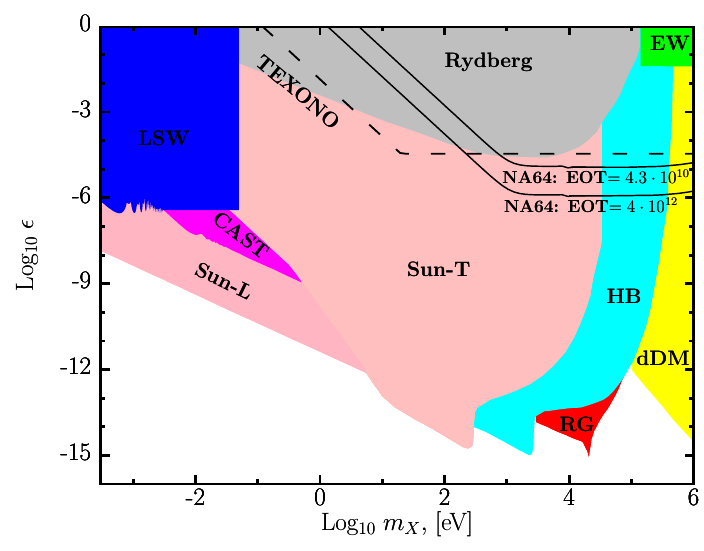
Figure 1 . Exclusion limits in the ( m X ; (cid:15) ) parameter plane of the hidden photon model evaluated from the direct searches in the NA64 [27, 28] (solid black lines) and TEXONO [6](dashed black lines) experiments in comparison with other results, see refs. [7, 29, 30] for